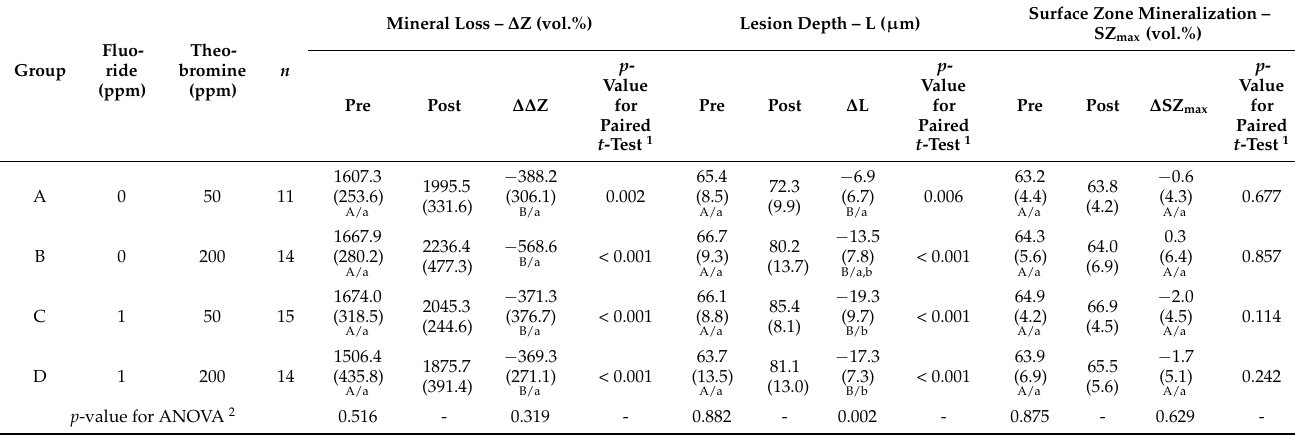
1 Paired t -test between pre- and post-secondary demineralization values for a particular parameter at 0.05 significance level. Different upper- case letters indicate statistically significant difference ( p < 0.05) between pre- and post- secondary demineralization for a particular parameter. 2 One-way analysis of variance for a particular parameter at pre-secondary demineralization or two-way analysis of variance for post- secondary demineralization between the four experimental groups at 0.05 significance level. Different lower-case letters indicate statistically significant difference ( p < 0.05) between experimental groups for a particular parameter at pre- or post- secondary